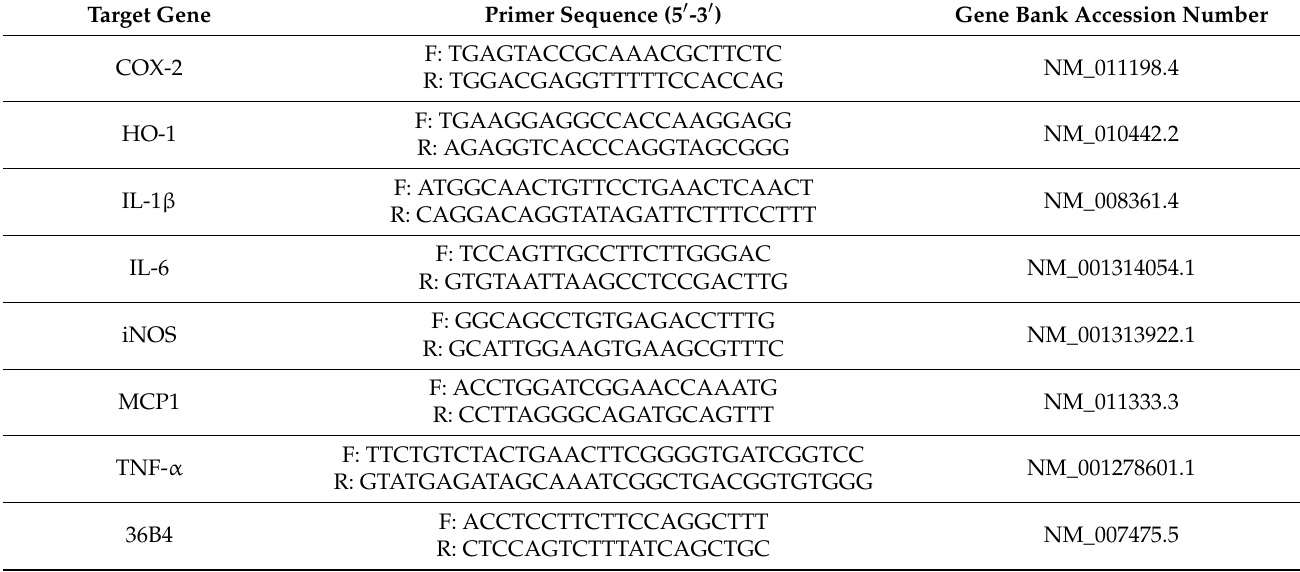
Table 1. Primers used for